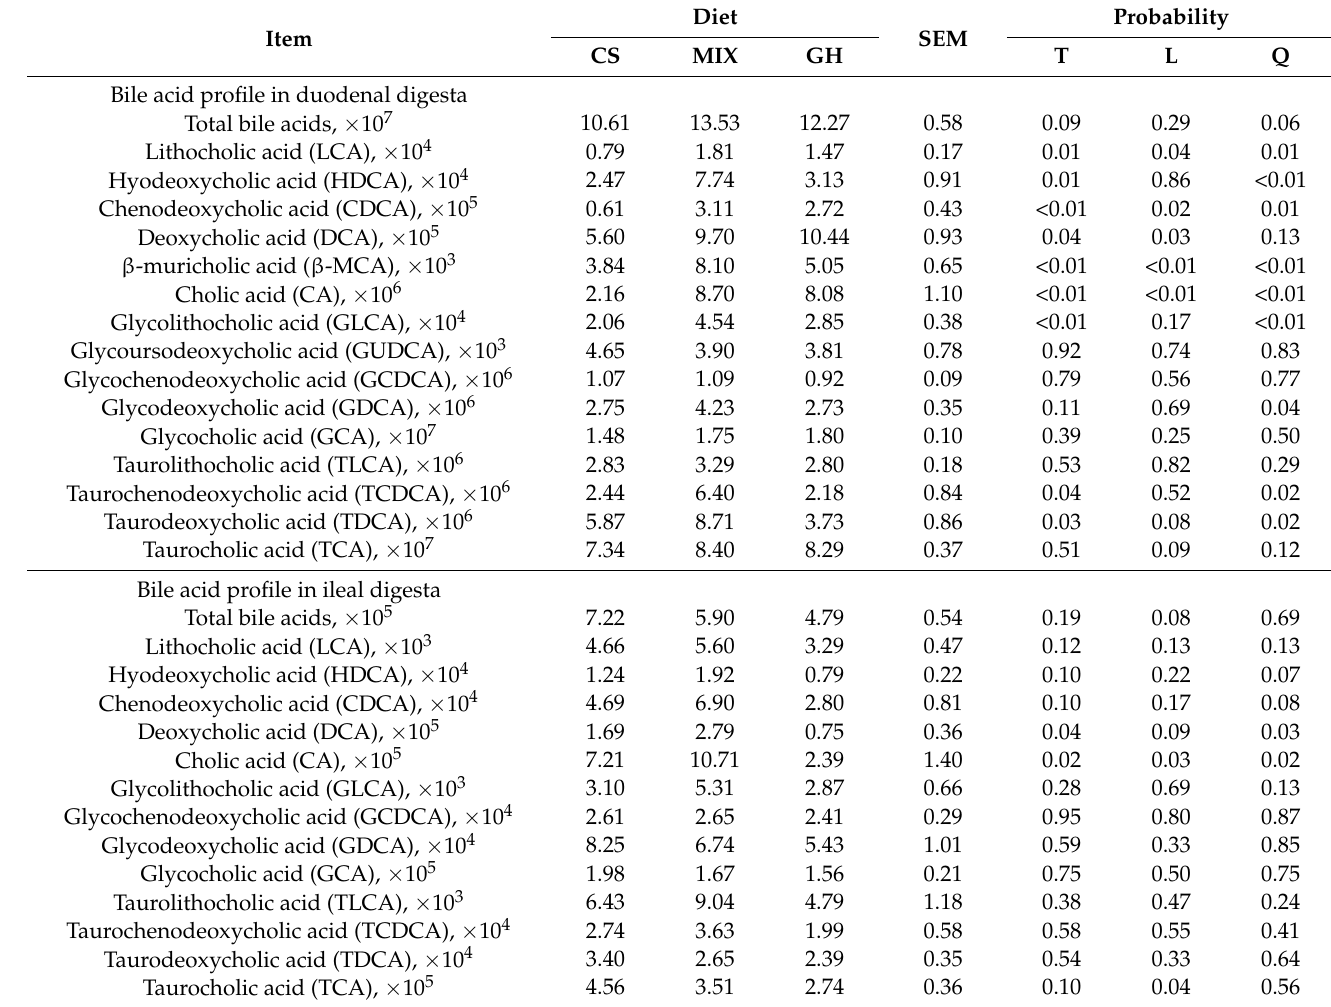
Table 5. Effects of different dietary forage sources on bile acid profile (ng/g of DM) in duodenal and ileal digesta of